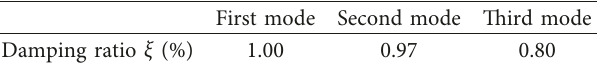
Figure 6: Flow chart of damping ratio calculation. Table 3: Calculation of the damping ratio of the CFRP motor